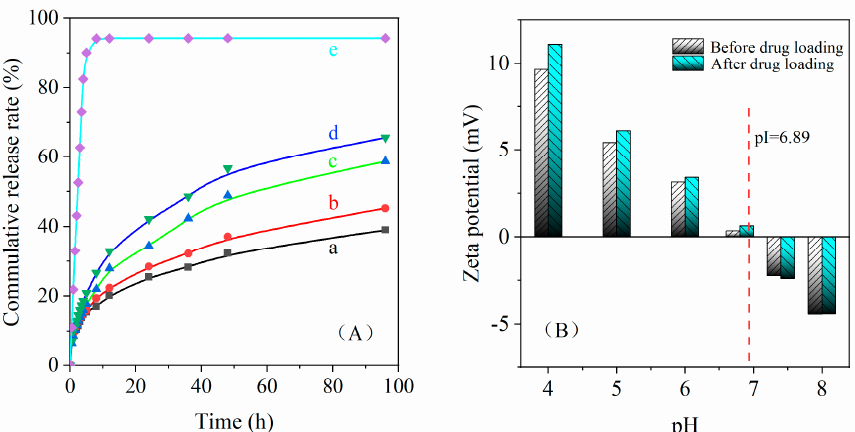
Figure 7. The release rate of PTX ( A , a. PTX loaded with CA ‐ CSNPs, pH=7.0; b. PTX loaded with CA ‐ CSNPs, pH=6.0; c. PTX loaded with CA ‐ CSNPs, pH=5.0; d. PTX loaded with CA ‐